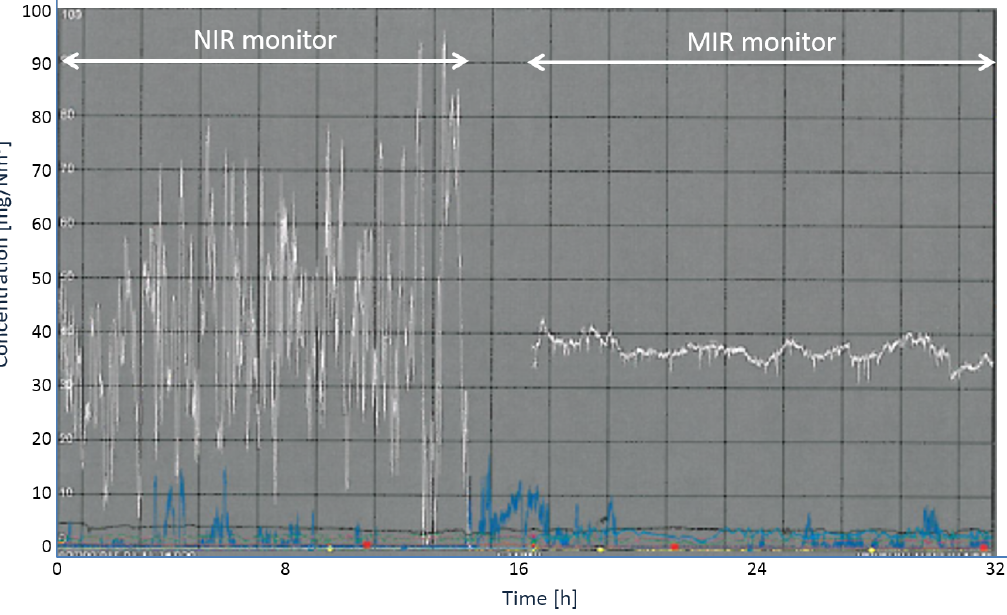
Figure 11. Nitric oxide concentration readings (white trace) with an NIR sensor ( left ) and an MIR sensor ( right ) at the same measurement point [17]. The blue trace depicts concentration readings of an NIR nitrogen dioxide (NO ) 2